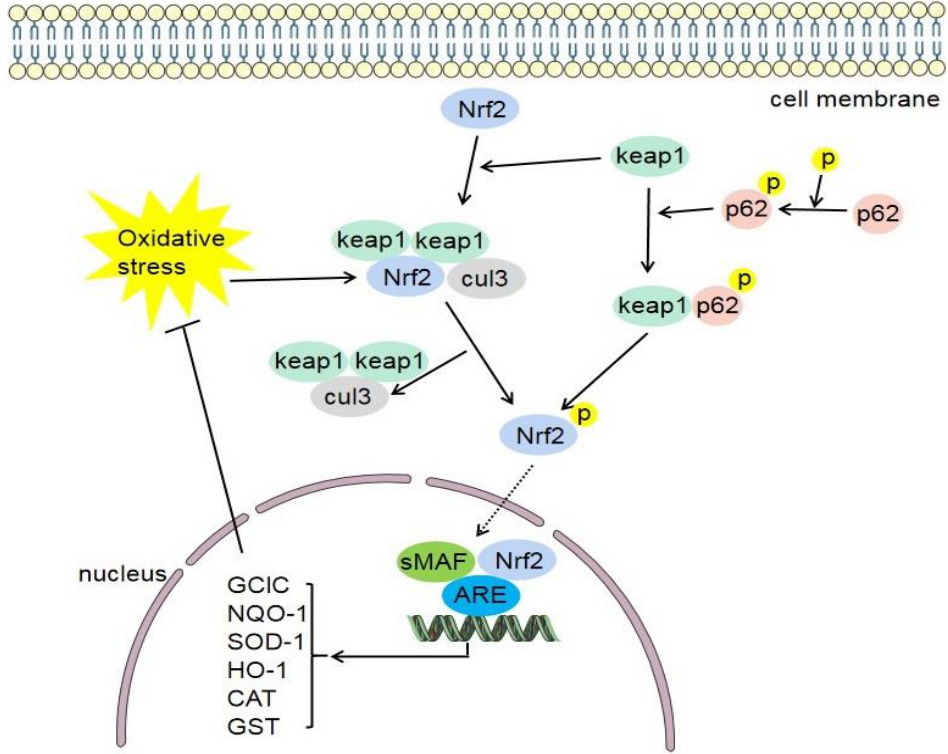
Figure 2. Keap1-Nrf2-ARE signaling pathway. Under normal physiological conditions, Keap1 binds to Nrf2 and makes it inactive. When oxidative stress occurs in the body, Nrf2 and Keap1 are dissociated and activated, transferred to the nucleus, and combined with the ARE in the nucleus. Fur- thermore, they can promote the activation of various target genes (GCLC, NQO-1, SOD-1, HO-1, CAT, GST, etc.) and inhibit oxidative stress in feedback. Keap1, cytoplasmic kelch-like epichlorohydrin- associated protein 1; Nrf2, nuclear factor erythroid 2-related factor 2; sMAF, small